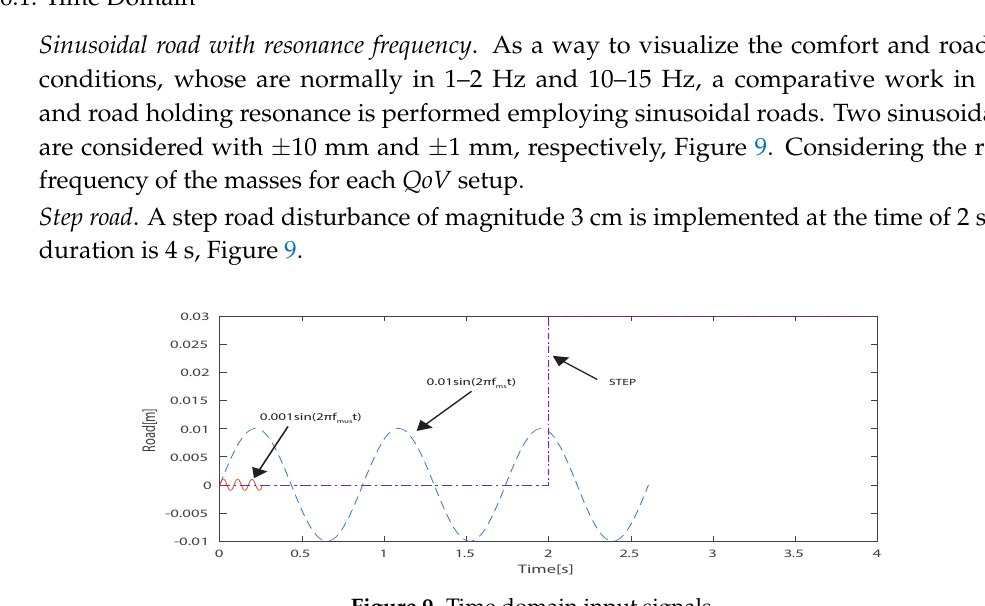
Figure 9. Time domain input signals.